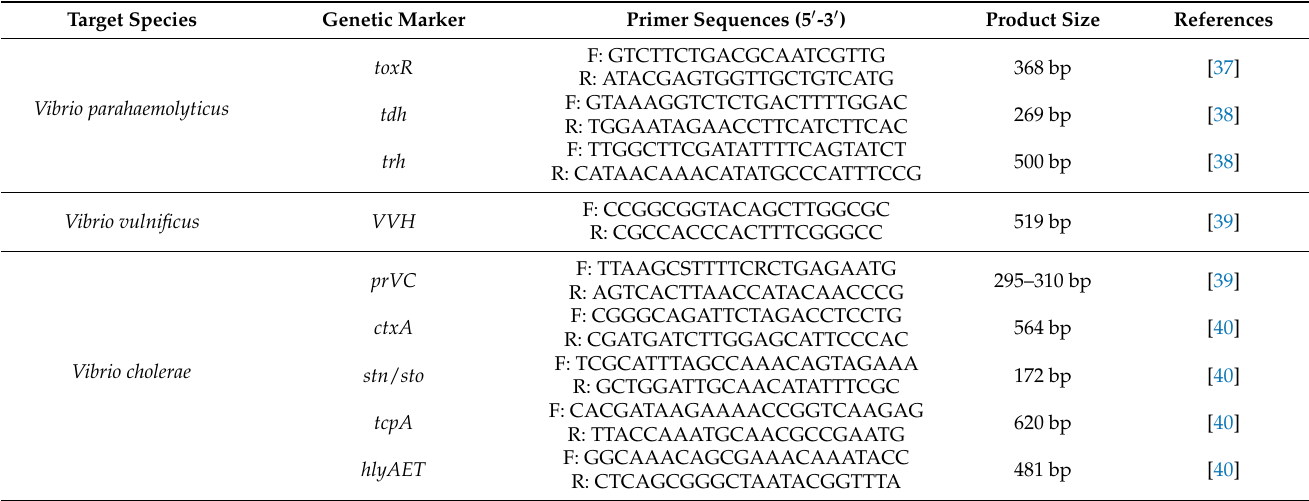
Table 1. Primer sequences used in this study and size expected for the specific